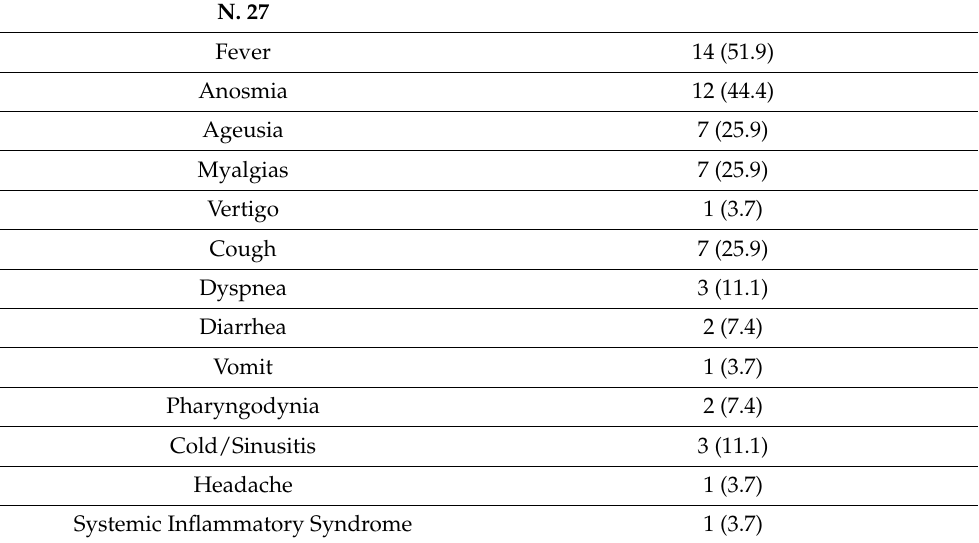
Table 2. Clinical features of symptomatic mothers with confirmed infection by SARS-CoV-2 at the delivery.